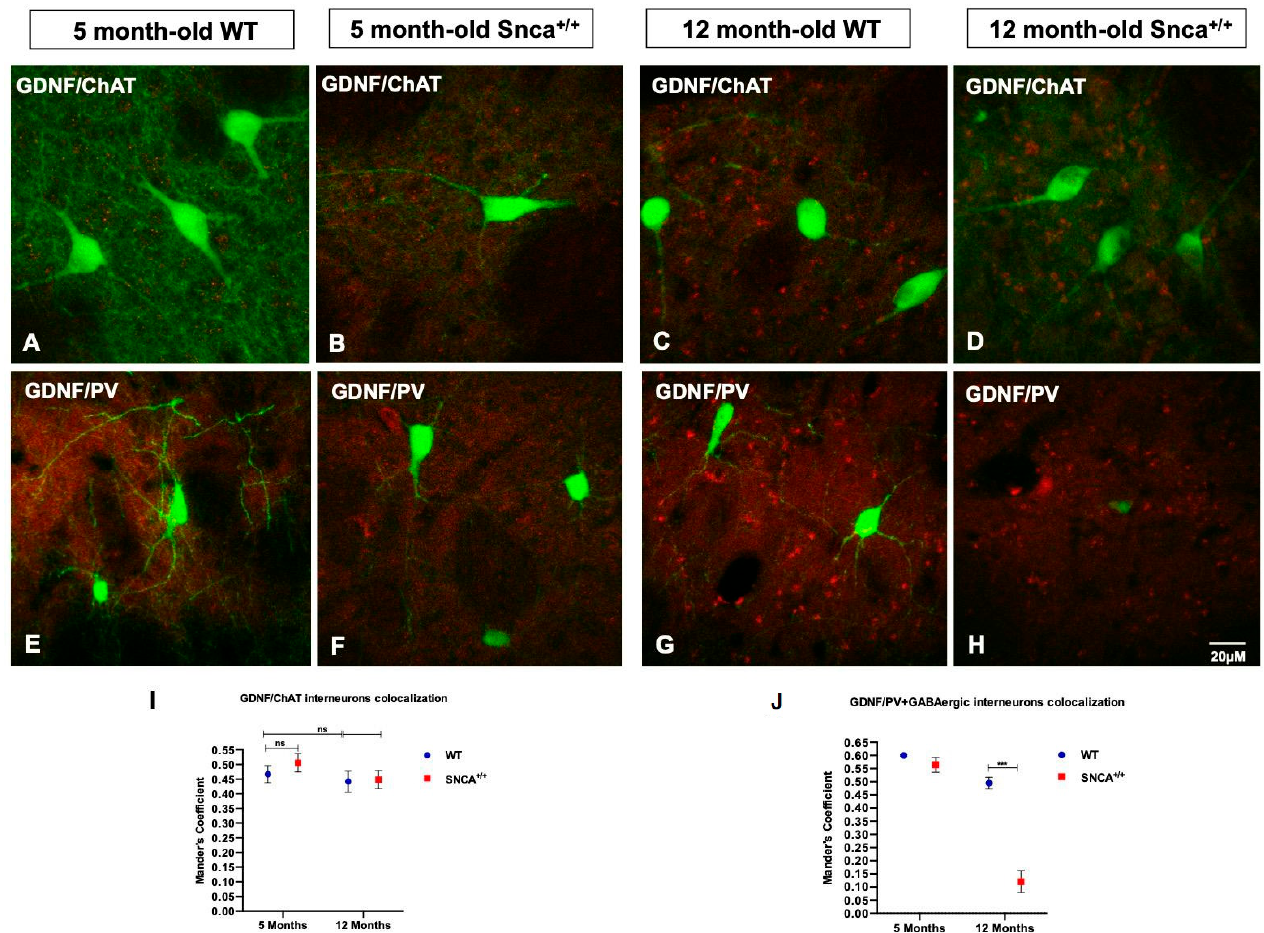
Figure 5. GDNF in striatal interneurons. ( A – D ) Representative confocal images show the immunoreaction intensity of ChAT and GDNF in each experimental group. ( E – H ) Images show the immunoreaction intensity of PV+ GABAergic neurons and GDNF in each experimental group. ( I – L ) Quantitative analysis of coexpression levels by Mander’s coefficient in all experimental groups. Histogram represents the mean of ROIs calculated on the basis of Mander’s coefficients, revealing the statistically significant colocalization of GDNF in ChAT- and PV-positive neurons, at *** p < 0.001, only in the 5-month-old WT and Snca +/+ rats. “ns” means “not significant”.